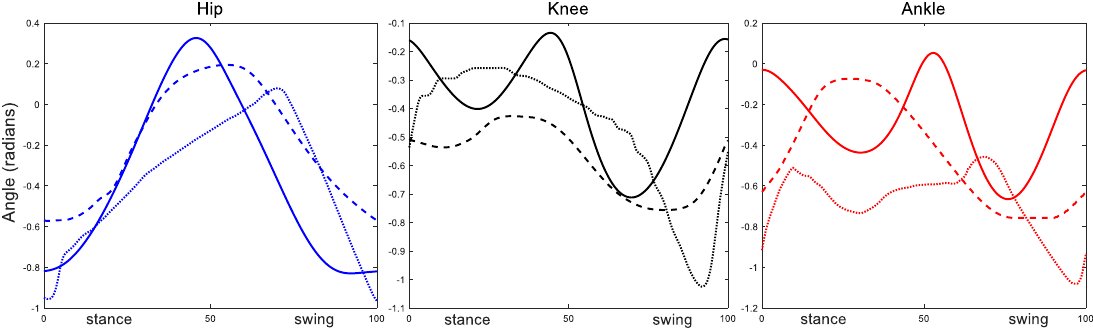
Figure 13. Comparison of animal joint motion profiles with simulation results. Animal data (solid lines); simulation results from this present work with the knee–ankle synergy (dashed lines); simulation results from our previous model [8] (dotted lines) with separate hip, knee and ankle pattern formation circuits.